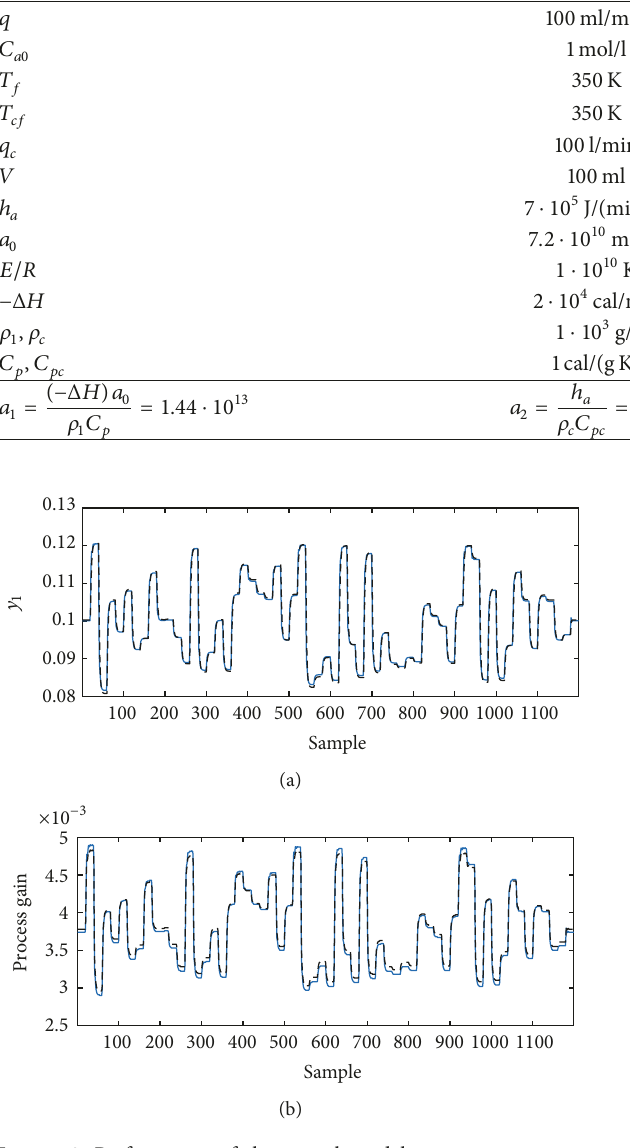
Figure 3: Performance of the neural model to reconstruct con- centration and Jacobian for CSTR in Case 1. (a) Concentration predicted by the neural model (black dashed line) and CSTR (blue line). (b) Process gain calculated with the neural model (black dashed line) and actual gain of the process (blue